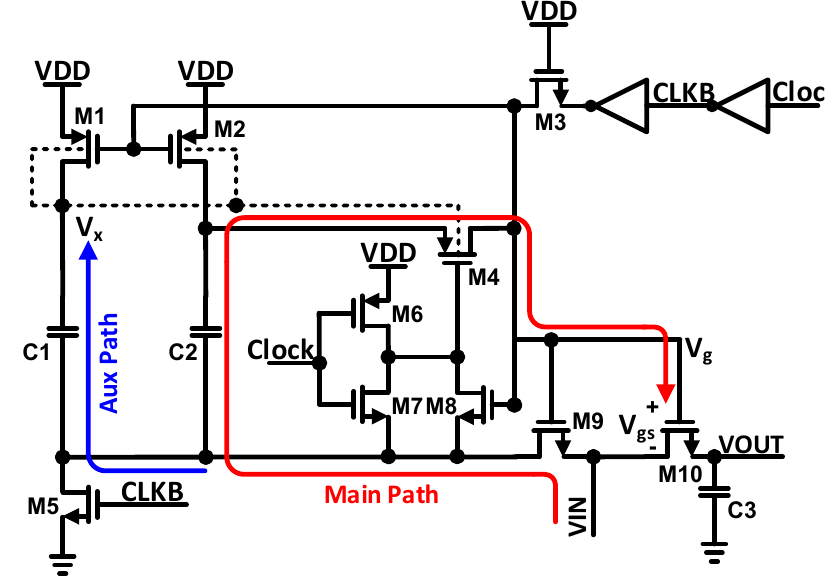
Figure 2. The schematic of the proposed bootstrap switch.